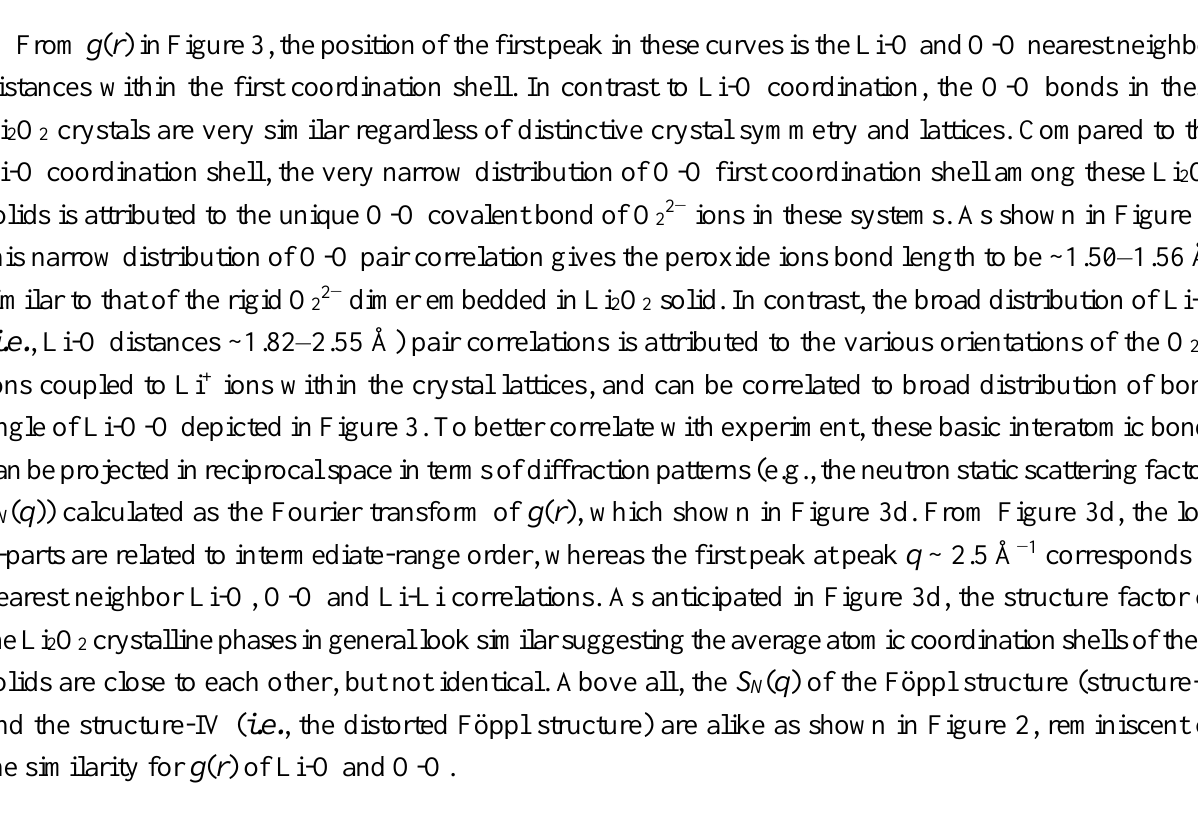
Figure 3. The Li 2 O 2 crystal structures pair distribution function g(r) of ( a ) O-O ( i.e. , g O-O (r)); ( b ) Li-O ( i.e. , g Li-O (r)); and the corresponding angular distribution function of ( c ) Li-O-O bonds; and ( d ) calculated neutron static structure functions for these Li 2 O 2